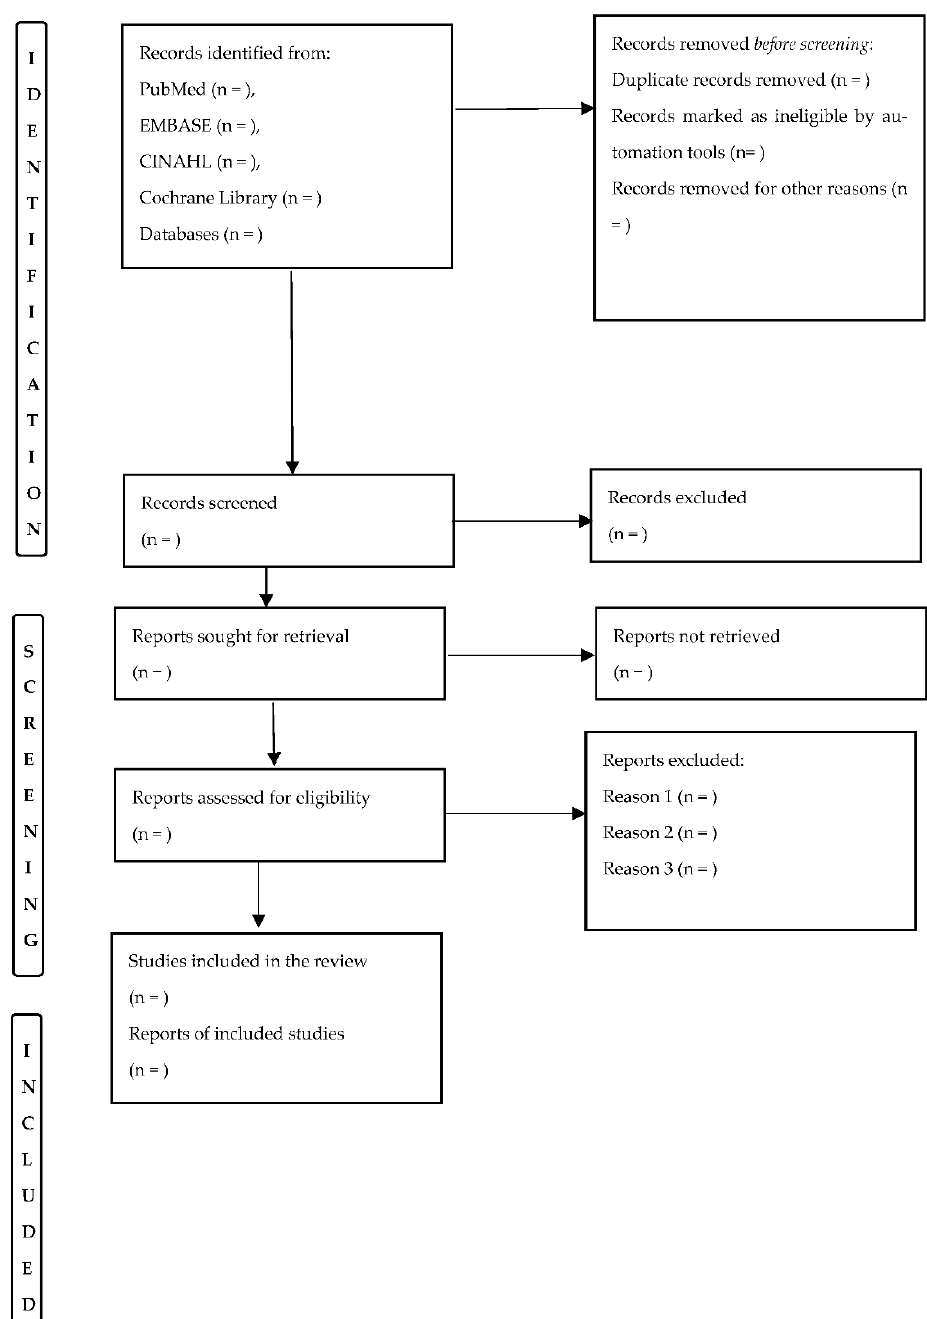
Figure 1. Selection of articles for inclusion in the systematic review (PRISMA-P).